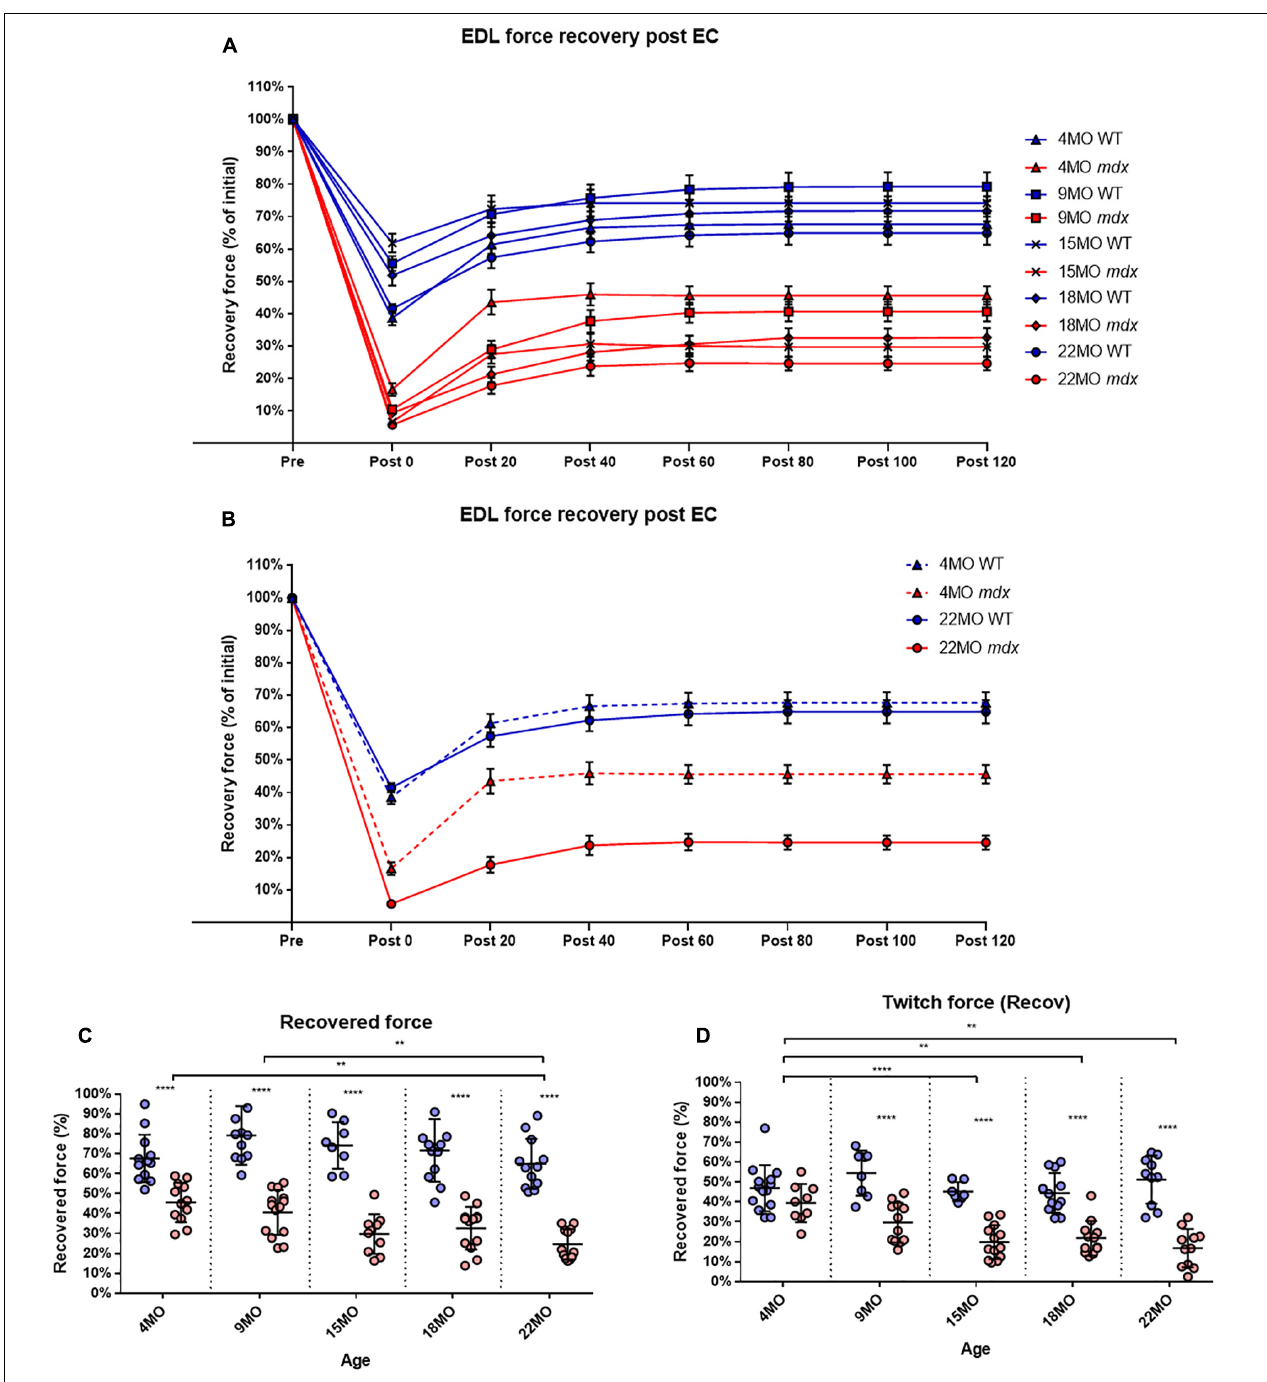
FIGURE 7 | Percentage force recovery for up to 120 min post EC protocol. Forces were normalized in each group with P max = 100%. (A) XY plot of post EC EDL force recovery over 120 min at 20-min intervals for mdx and littermate controls across all age groups. (B) For clarity, 4 and 22-month-old age groups have been isolated to highlight the differences in post EC recovery across these contractions. Data shown in these curves are mean ± SD. (C) Interleaved scatterplots of the recovery at 120 min across 4-month ( n = 13 control; n = 12 mdx ), 9-month ( n = 11 control; n = 14 mdx ), 15-month ( n = 8 control; n = 10 mdx ), 18-month ( n = 12 control; n = 13 mdx ), and 22-month ( n = 12 control; n = 12 mdx ) age groups (Note: these numbers apply to A–C ). (D) Interleaved scatterplots of the twitch force recovery at 120 min across 4-month ( n = 14 control; n = 9 mdx ), 9-month ( n = 11 control; n = 12 mdx ), 15-month ( n = 7 control; n = 13 mdx ), 18-month ( n = 12 control; n = 12 mdx ), and 22-month ( n = 10 control; n = 11 mdx ) age groups. For interleaved scatterplots in (C,D) , the horizontal line indicates the mean value ± SD. Statistical differences between age groups are displayed above the graph, statistical differences displayed within graphs are differences between genotypes assessed by two-way ANOVA, post hoc analysis using Sidak’s multiple comparisons test. **** P < 0.0001, **0.001 < P < 0.01.